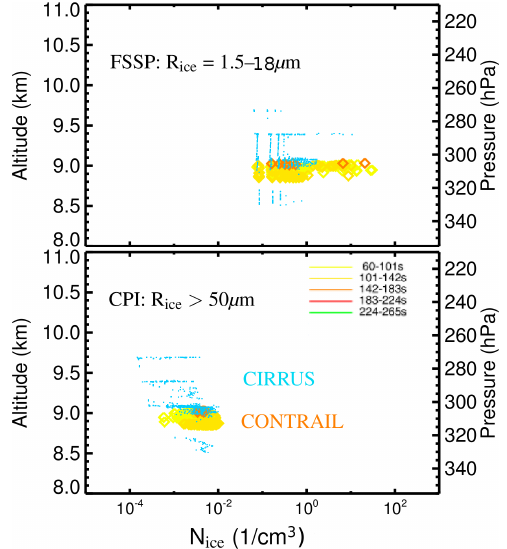
tions, labeled 1 – 3 in the following.